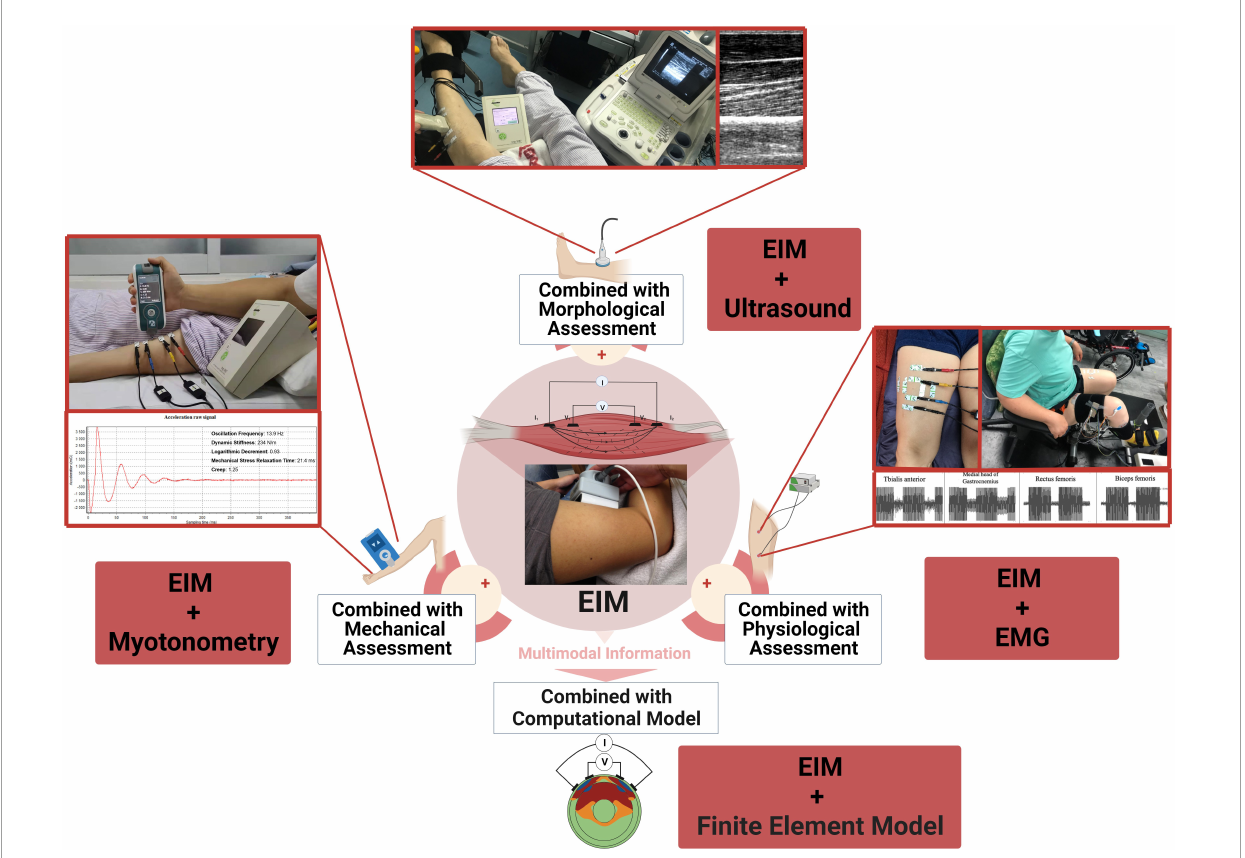
FIGURE1 Conceptual illustration of combining EIM with other technologies for muscle function evaluation.